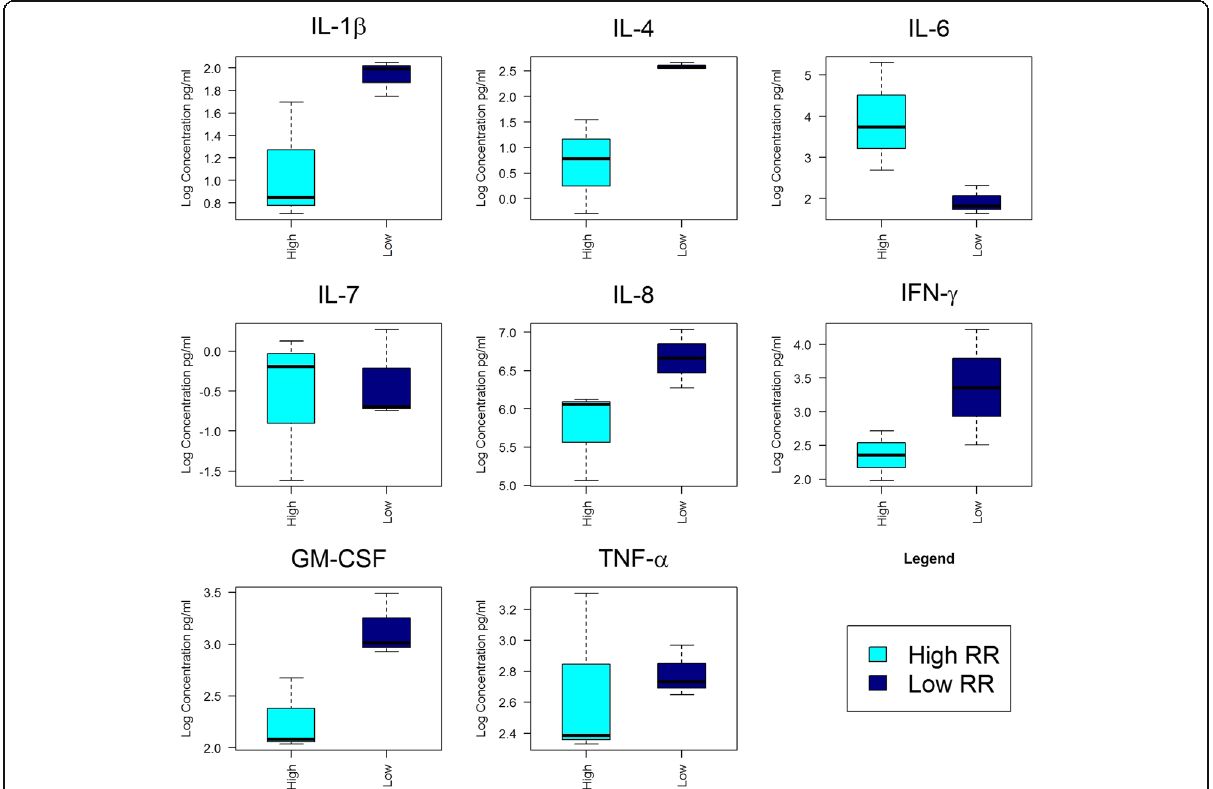
Fig. 3 Box plot distribution for average cytokine values from high and low root resorption participants